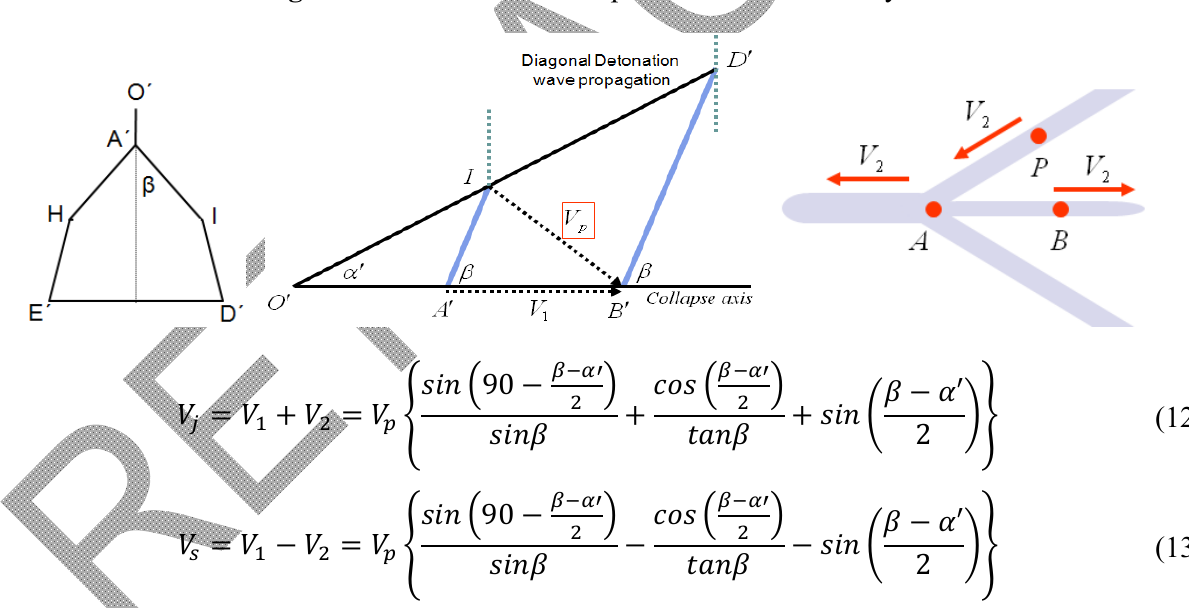
Figure 6. Geometrical description of Birkhoff